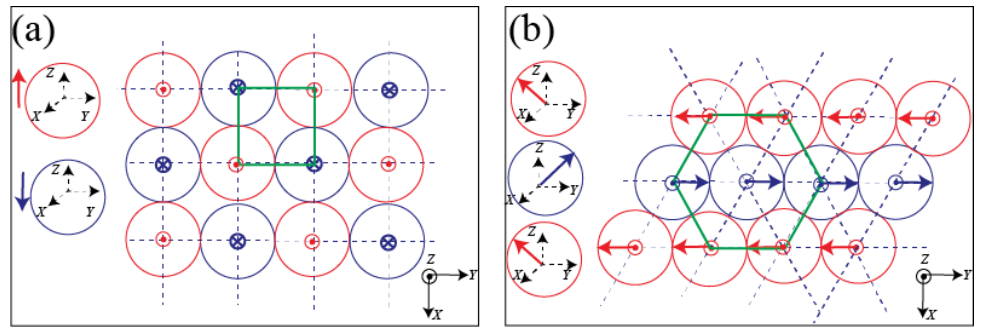
Figure 9. Suggested models for the orientation of electric dipoles of microdroplets with a square ( a ) and a hexagonal ( b ) lattice organization: the tilting of the direction of electric dipoles of droplets by an angle of + 45 ◦ and − 45 ◦ , respectively, may explain the transition from a square organization to a hexagonal organization and hence the coexistence of both types of organization of